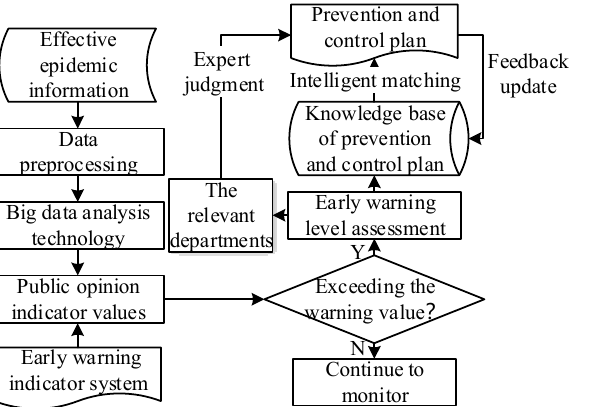
Figure 3. The specific working process of the epidemic information public opinion early warning model.